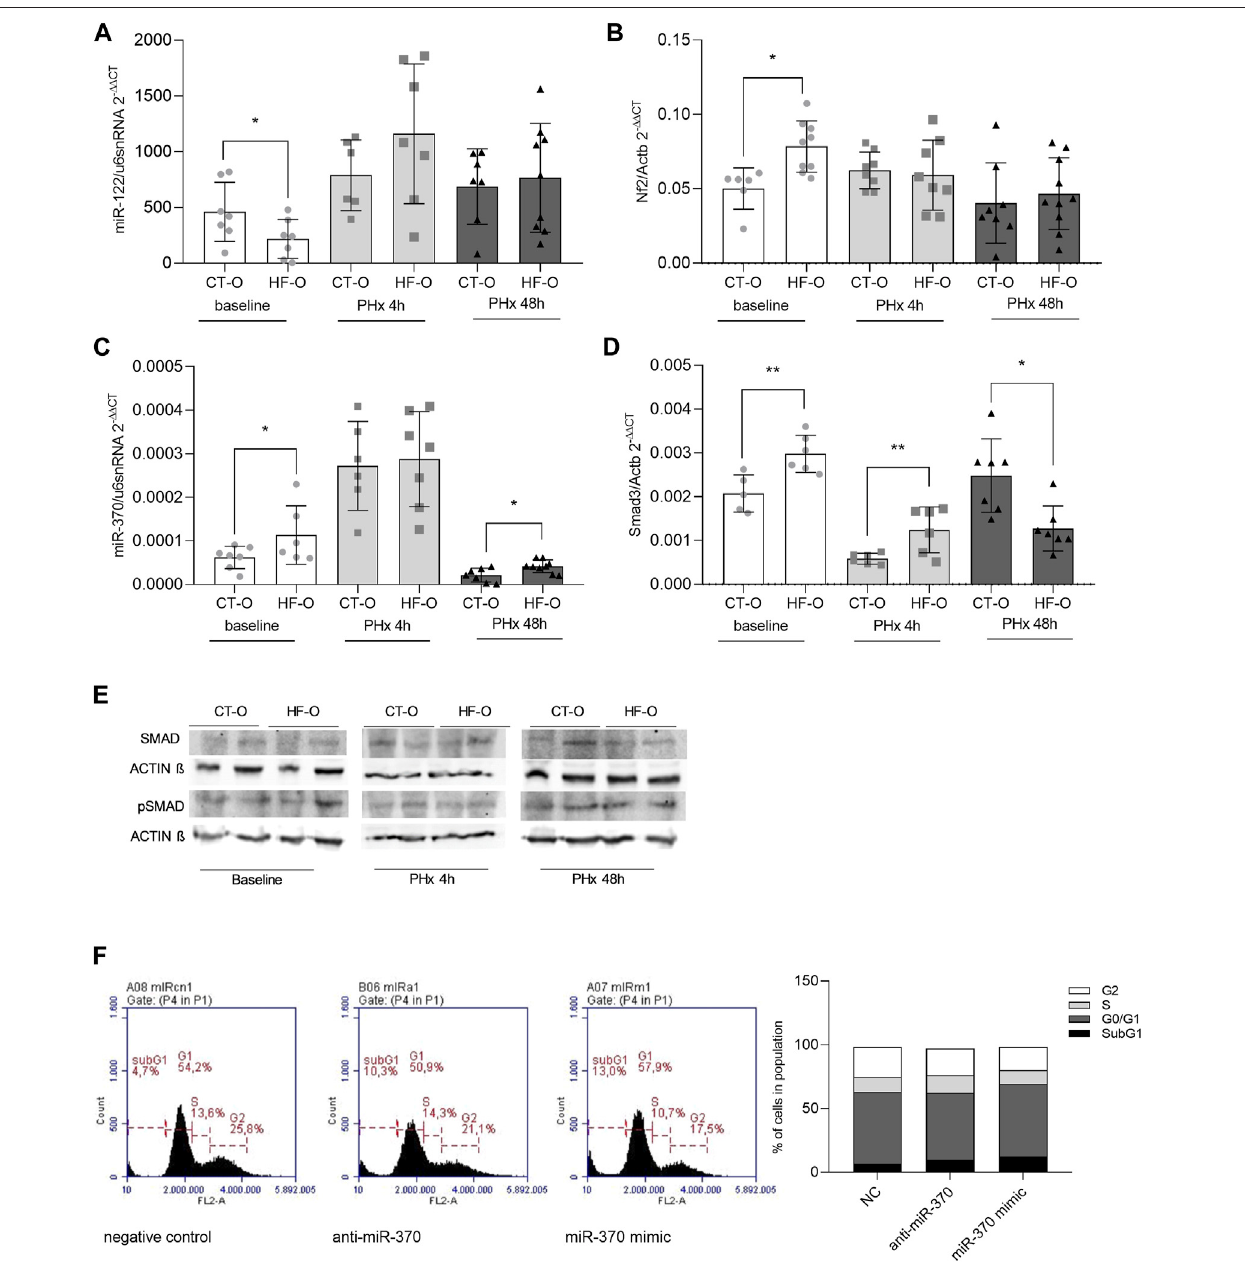
FIGURE 2 | Hepatic miR-122 and miR-370 pathways in the liver of the offspring of control and obese dams after partial hepatectomy. Hepatic miR-122-5p (A) , Nf2 (B) , miR-370-3p (C) , and Smad3 (D) gene expression (qPCR) and SMAD3 and pSMAD3 immunoblotting (E) from the offspring of control (CT-O) and obese (HF-O) dams, before (baseline) or 4 h (PHx 4 h) or 48 h (PHx 48 h) after partial hepatectomy surgery. Data are plotted as individual values (dot plots), means and SEM, representedbyverticalbars. n =5 – 10/group.* p ≤ 0.05and** p ≤ 0.005afterStudent ’ s t -test(CT-OversusHF-O).Representativeimageandhistogramofcellcycle distribution ( n = 2) by fl ow cytometry in AML12 cells transfected with negative control, anti-miR-370, or miR-370 mimic (F) .